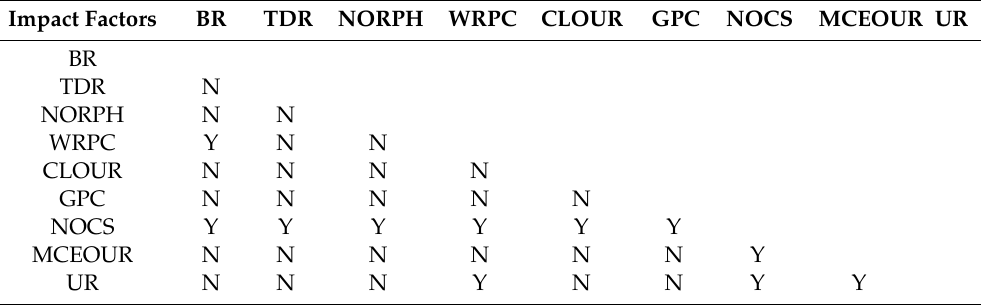
Table 7. Statistical significance of the differences in PD values among different factors.